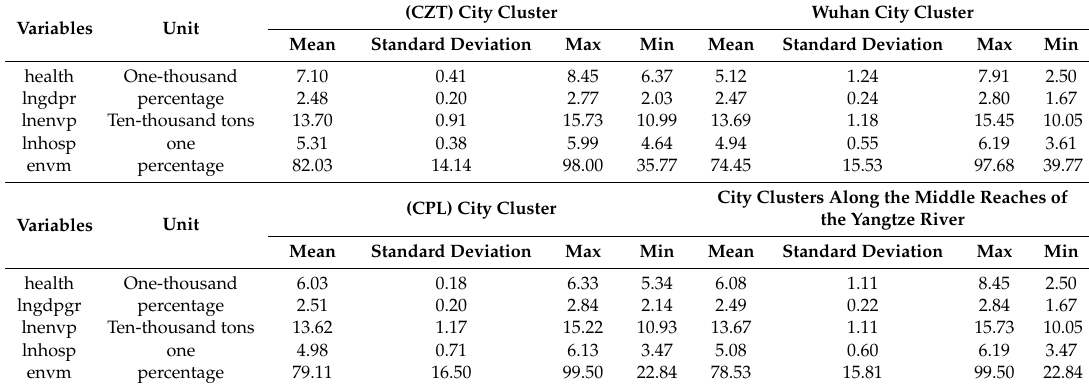
Table 1. Statistical description of the variables. CZT: the Changsha-Zhuzhou-Xiangtan city cluster. CPL: the circum-Poyang Lake city cluster. health: the health of residents is measured by the mortality rate; lngdpr: the logarithmic form of the regional GDP growth rate; Inenvp: the logarithmic form of environmental pollution; Inhosp: the logarithmic form of the number of medical institutions; envm: the average rate of the municipal sewage treatment rate, the comprehensive utilization rate of industrial solid waste and the harmless treatment rate of household